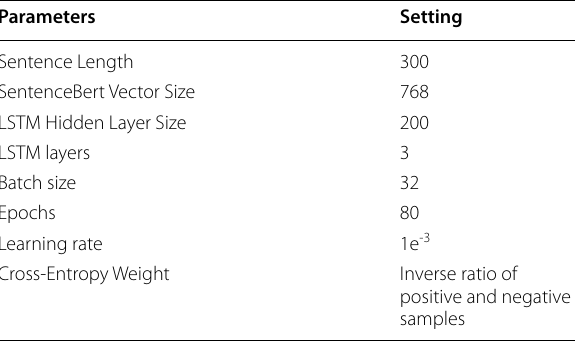
Table 10 Model parameter